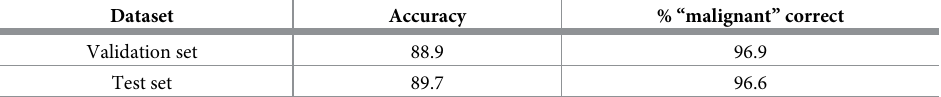
Table 6. Accuracy and percentage of “malignant” slides correctly classified for final model on validation and test